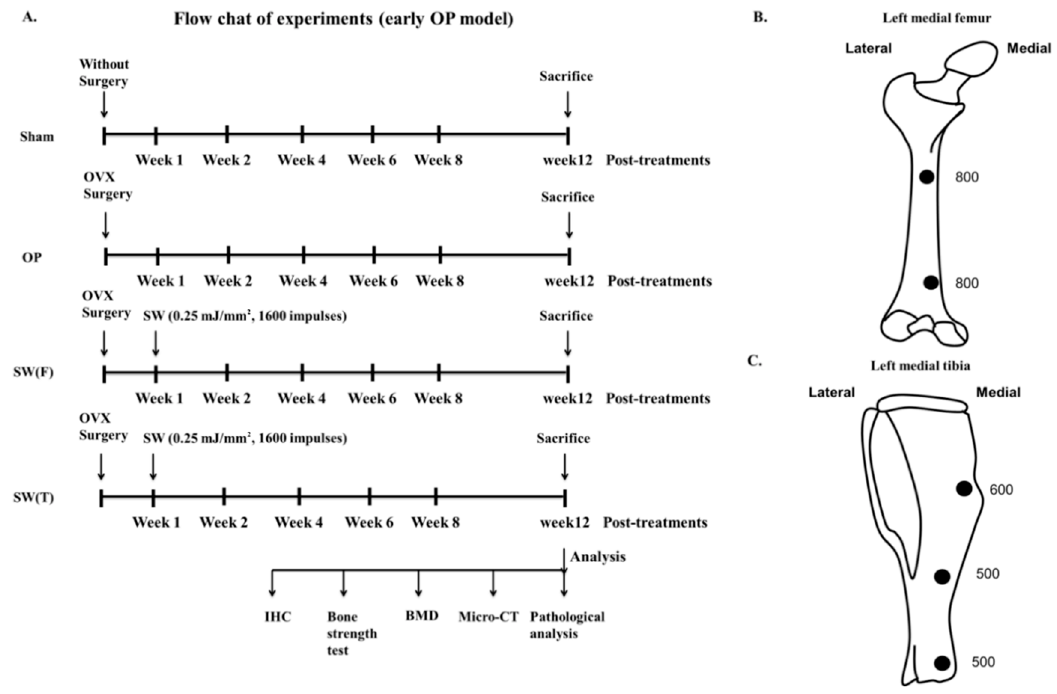
Figure 1. Study design: ( A ) the figure indicates the performance of surgery, treatment, sacrifice of rats, and analysis in each group. Shockwave (SW) application was focused ( B ) on the left medial femur (SW(F)) with 800 impulses or ( C ) on the left tibia (SW(T)) with 600, 500 and 500 impulses at 0.5 cm below the skin of the rat at each location selected (black circles). Osteoporosis is denoted OP. The ovariectomized is denoted OVX. Immunohistochemistry is denoted IHC. The bone mineral density is denoted BMD and micro computed tomography is denoted